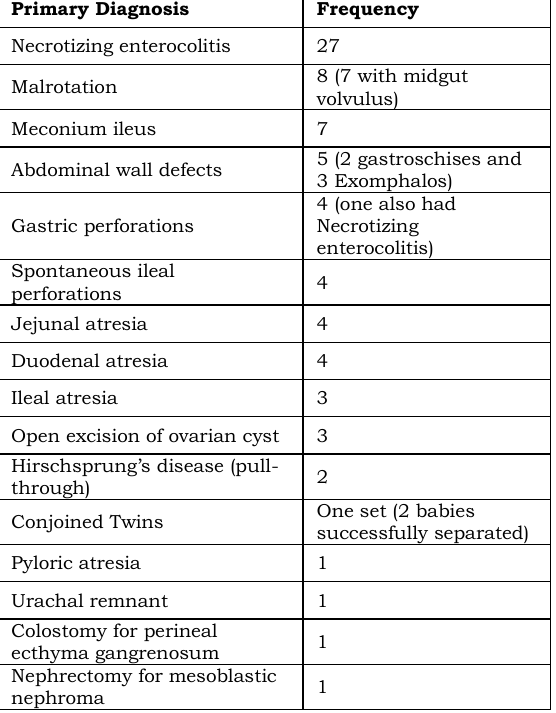
Table 2: Primary diagnosis in babies undergoing